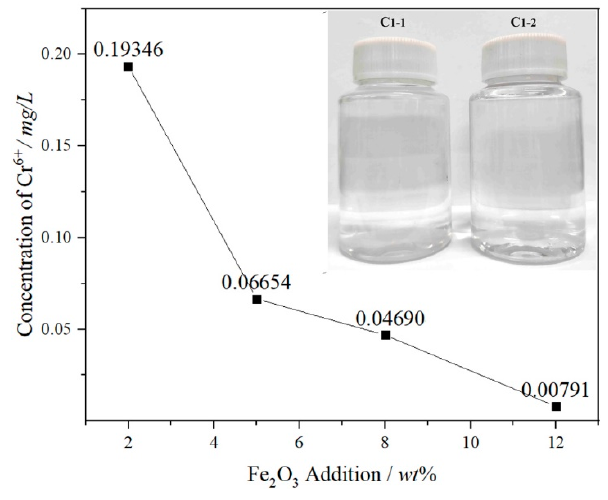
Figure 9. Color of leaching solutions and concentration of Cr 6+.